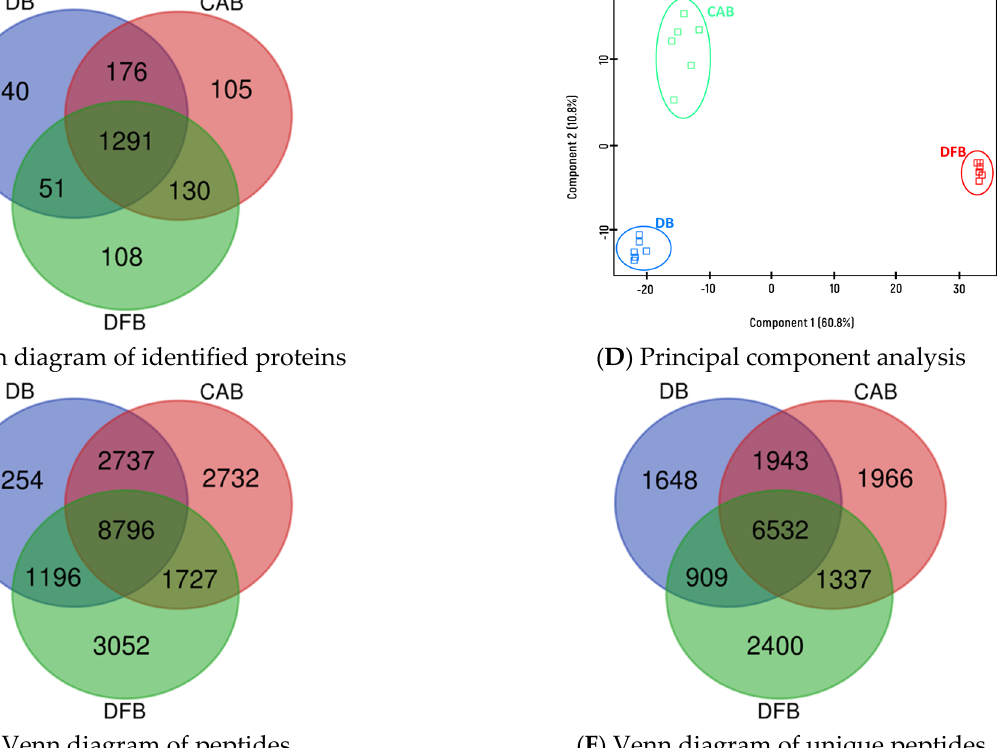
Figure 1. ( A ) Extraction efficiency. Box plot presenting results of protein extraction efficiency (*** p < 0.001; * p < 0.05); ( B ) Number of identified peptides. Box plot presenting number of proteins identified (*** p < 0.001); ** p < 0.01); ( C ) Venn diagram of identified peptides. Venn diagram showing the number of proteins identified, and the number of proteins characteristic for each type of homogenate; ( D ) Principal component analysis; ( E ) Venn diagram of peptides. Venn diagram presenting number of peptides identified, and the number of peptides characteristic for each type of homogenate; ( F ) Venn diagram of unique peptides. Venn diagram presenting number of unique peptides identified, and the number of unique peptides characteristic for each type of homogenate.